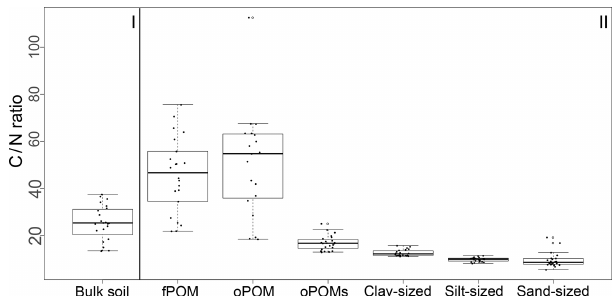
Figure 3. C / N ratios of bulk soils (I) and SOM fractions (free particulate OM – fPOM, occluded particulate OM – oPOM, small occluded particulate OM – oPOMs – and clay-sized mineral- associated OM – MAOM)